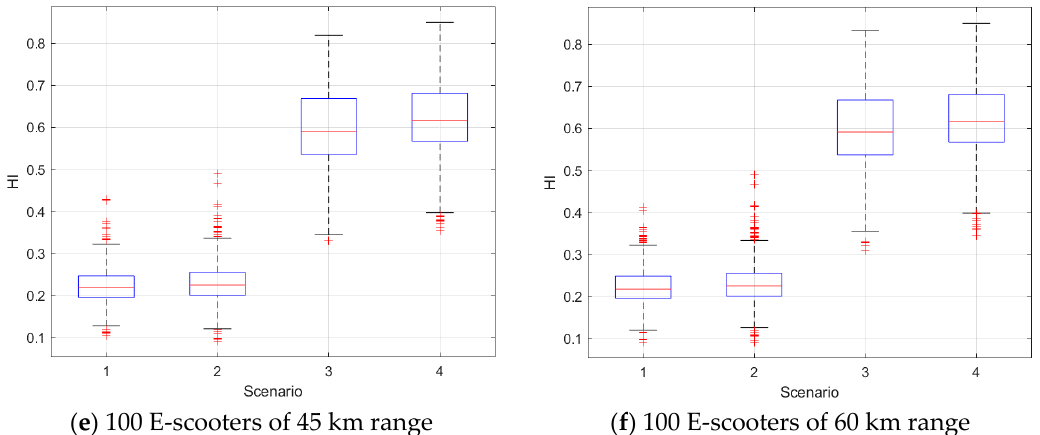
Figure 2. HI results at different scenarios, number of e-scooters at each census tract, and battery ranges.